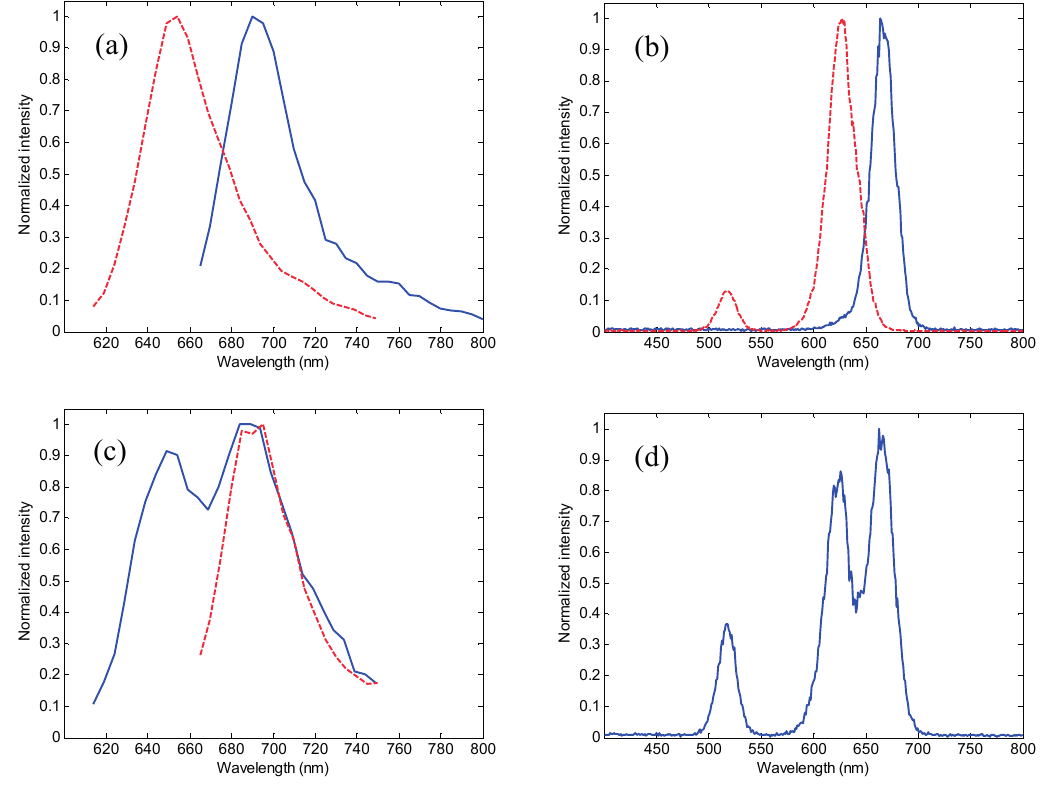
Figure 4. Fluorescence and standard SF spectra of methylene blue, oxazine 170, and their mixture. ( a ) conventional fluorescence emission spectra of methylene blue (blue solid line) and oxazine 170 (red broken line); ( b ) standard SF spectra of methylene blue (blue solid line) and oxazine 170 (red broken line); ( c ) conventional fluorescence spectra of the mixture of methylene blue and oxazine 170, excited at 614 nm (blue solid line) and 655 nm (red broken line); and ( d ) standard SF spectrum of the mixture of methylene blue and oxazine 170 (wavelength interval of 20